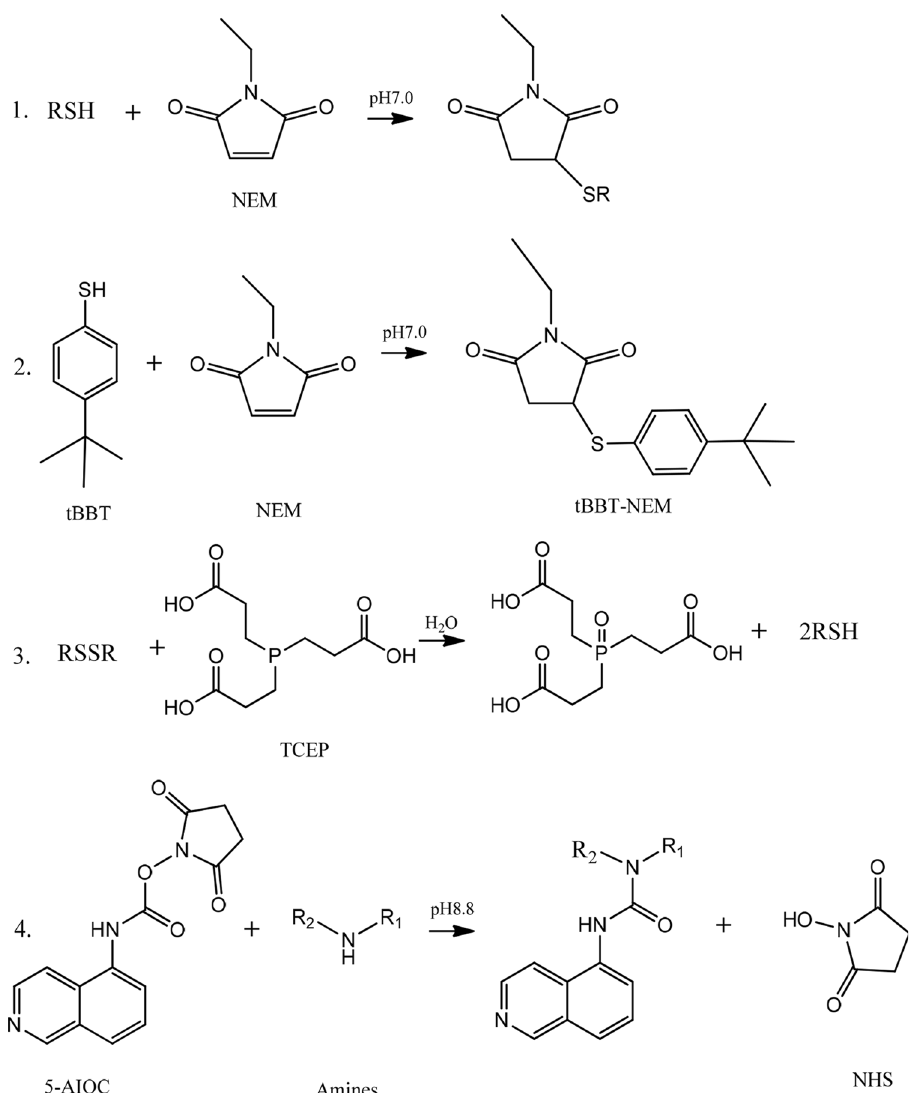
Figure 2. Schemes for 5-AIQC derivatization of amino analytes with thiol and disulfide groups in one